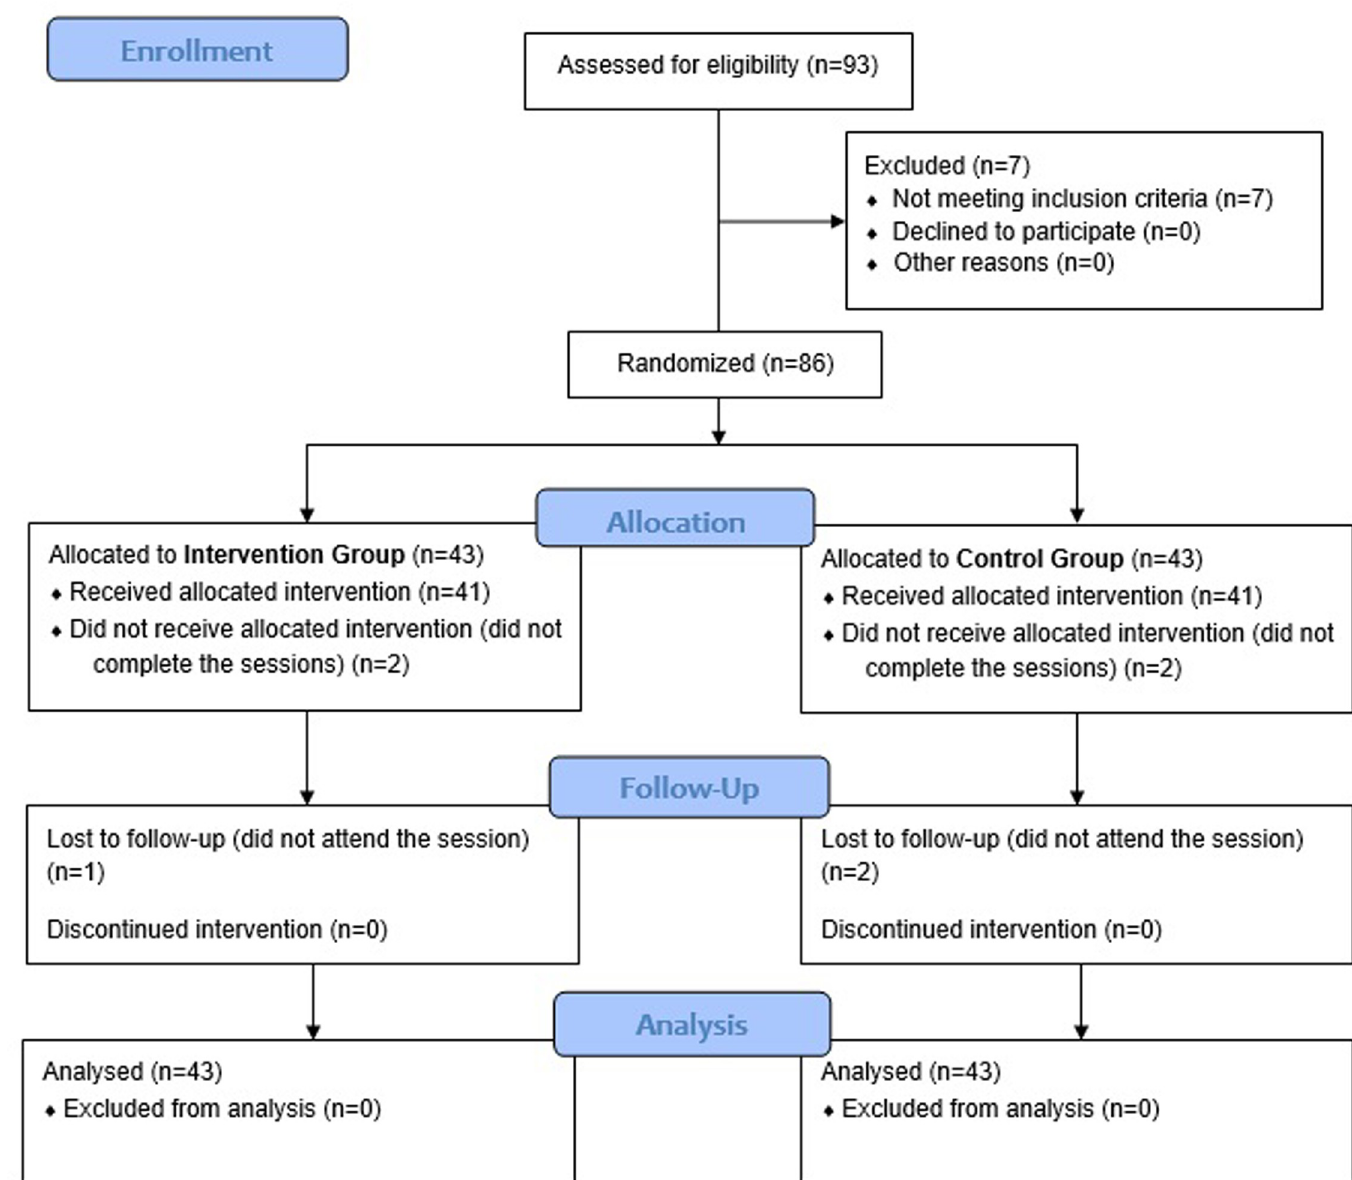
Fig 1. Study flow chart in accordance with the consolidated standards of reporting trials